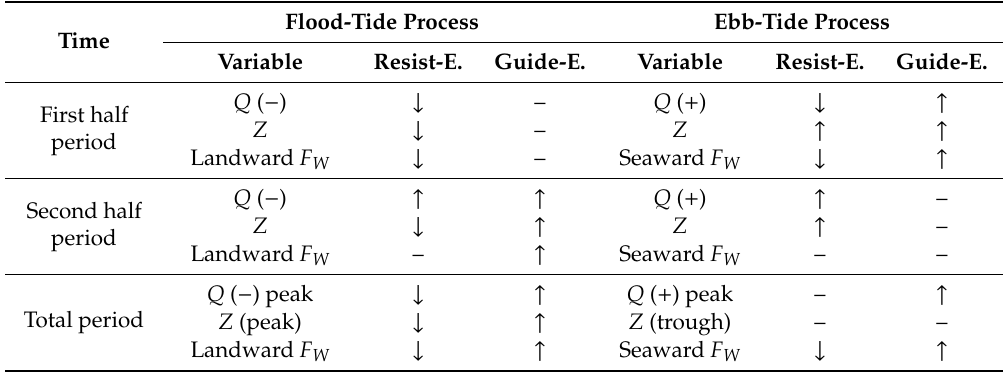
Table 2. Responses of tidal variables at cross-sections along the North Branch to the GYS regulation. Flood-Tide Process Ebb-Tide Process Time Variable Resist-E.